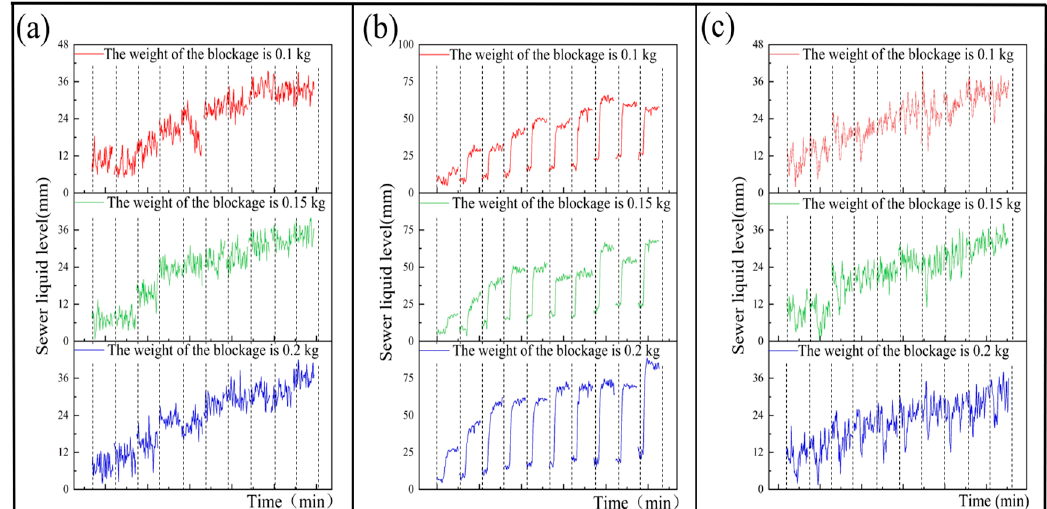
Figure 6. When the flow rate in the sewer ranges from 0.5 to 5 m 3 /h, the liquid level change in the upstream and downstream of the blocking point in the pipeline of DN200 at PW5: ( a ) The liquid level change of DN150 sewer at PW3, and it is 24.85 m upstream of the blocking point. ( b ) The liquid level change of DN200 sewer at PW4, and it is 4 m upstream of the blocking point (PW4). ( c ) The liquid level change of DN200 sewer at PW6, and it is 26.85 m downstream of the blocking point. The liquid level change rate and fluctuation range of the DN200 drainage pipeline under normal oper- ating conditions and after blocking are shown in Table S1 of the annex. Annex Table S1 shows that the flow of the DN200 drainage pipe exceeds 1 m 3 /h; the minimum liquid level rise rate at 4 m upstream of the blocking point is greater than the normal liquid level fluctuation, and the liquid level rise amplitude at 4 m upstream of the blocking point exceeds 300%. For flow that is below 1 m 3 /h, the liquid level change rate upstream of the blocking point basically coincides with the range of liquid level change rate caused by normal liquid level fluctuation. When the flow rate is 0.5 m 3 /h, the liquid level at 4 m upstream of the blocking point rises from 6 mm to 17 mm, which is greater than the liquid level rise caused by normal liquid level fluctuation. In addition, this liquid level rise fluctuation is the minimum liquid level rise amplitude upstream of the blocking point after DN200 drainage pipe is blocked under this flow rate. That is, at a flow rate ranging from 0.5 to 5 m 3 /h, the blocking identification of the downstream of the level monitoring point of DN200 drainage pipeline can be completed through the two limiting conditions of the liquid level change rate and the liquid level fluctuation range. Under normal conditions, the minimum liquid level change rate of DN200 drainage pipeline is included in the range of liquid level change rate downstream of the blocking point, and the minimum liquid level drop fluctuation monitored downstream of the blocking point exceeds the maximum liquid level drop fluctuation under normal conditions. In addition, abnormal liquid level drop fluctuation can be monitored severally downstream of the blocking point. Based on this, when the flow ranges from 0.5 to 5 m 3 /h, the blocking identification of the sewer upstream of the liquid level monitoring point can be completed by the two conditions of the liquid level change rate and the liquid level change range.